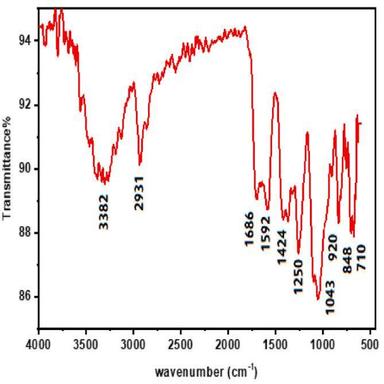
FTIR spectrum of PVA structure.